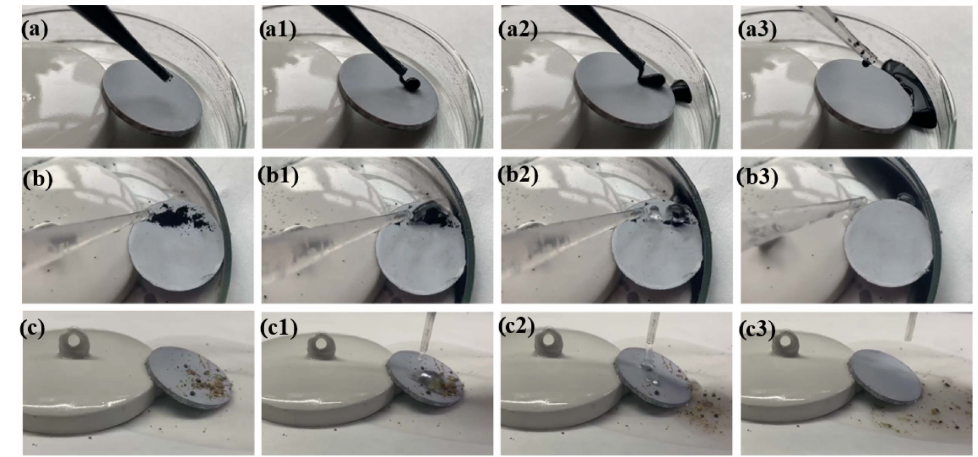
Figure 4. Self-cleaning ability of superhydrophobic coating: ( a ) ink; ( b ) MnO powder; ( c ) dust. Self-cleaning process ( a1 – a3 ); Self-cleaning MnO powder process ( b1 – b3 ); Self-cleaning dust process ( c1 – c3 ).